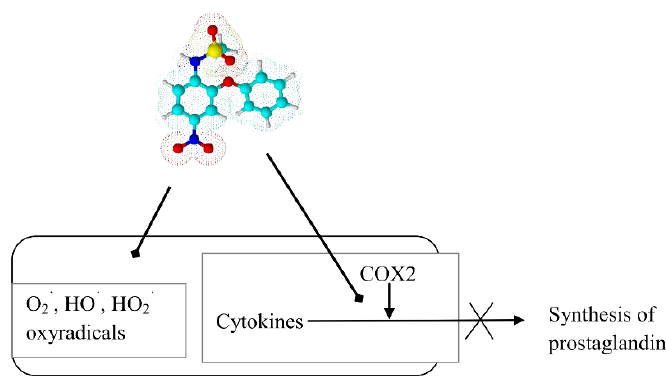
Scheme 6. Sites of action of nimesulide in cellular inflammation.